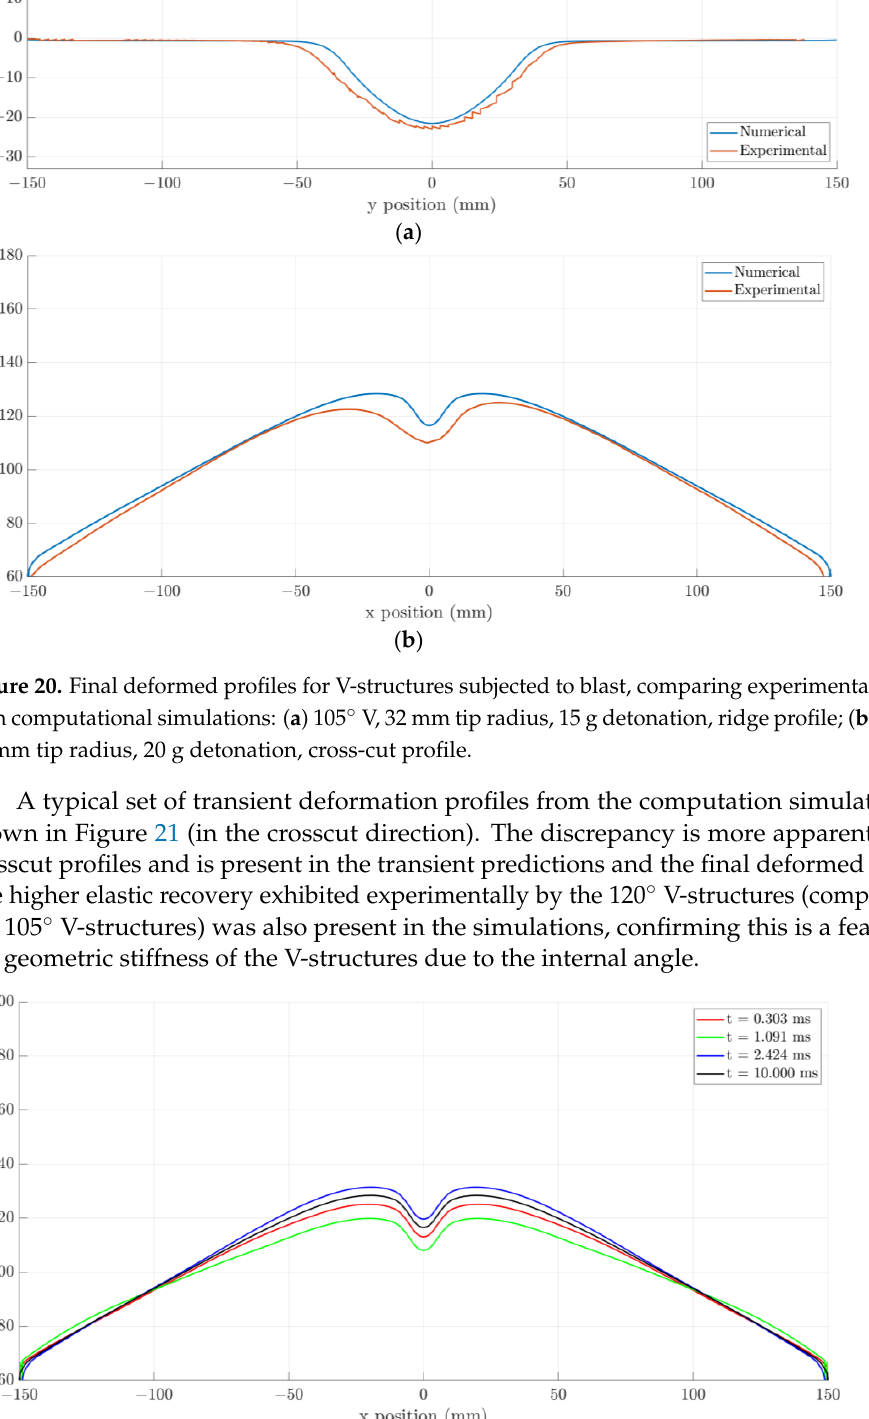
Figure 19. Graph of transient midpoint displacement versus time for a 120° V-structure with a 32 mm tip radius subjected to a 15 g detonation, comparing experimental and simulated data.